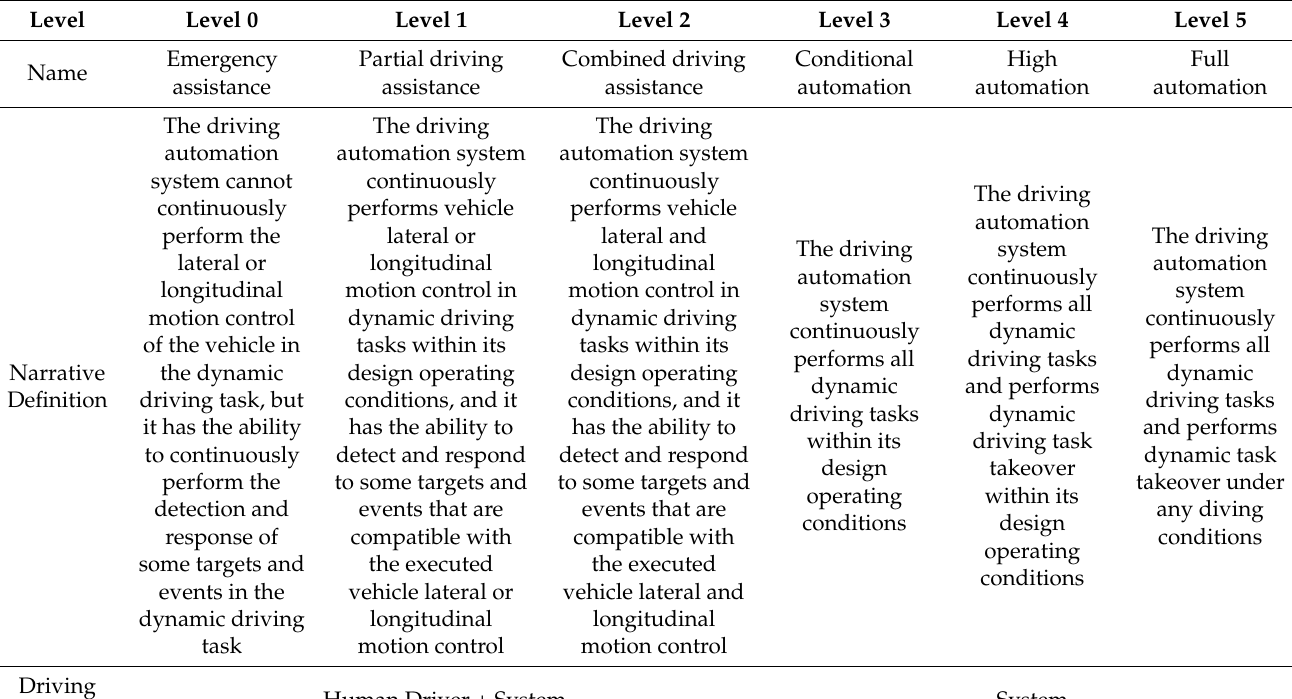
Table 3. Taxonomy of driving